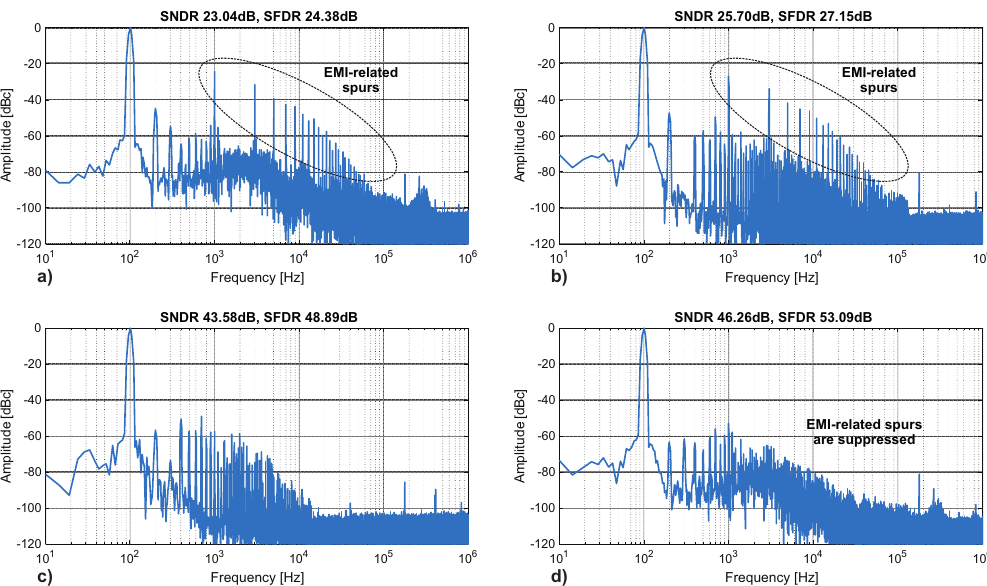
Figure 10. Spectra of the measured signals under 0dBm AM EMI excitation reported in Figure 9: ( a ) OPA2277 opamp output voltage with EMI injection; ( b ) MCP6V02 opamp output voltage with EMI injection; ( c ) nominal input signal spectrum as in Figure 8b; ( d ) Output voltage with EMI injection estimated starting from the EMI corrupted waveforms in ( a , b ), by the proposed EMI-induced errors suppression procedure with α = 0.445.